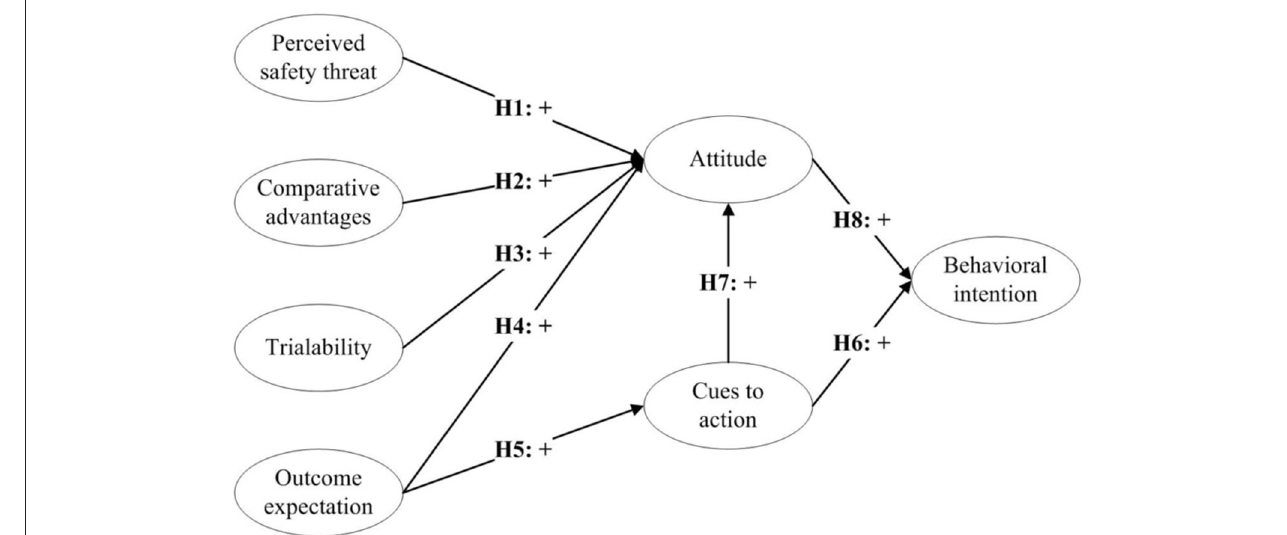
FIGURE 1 | Conceptual